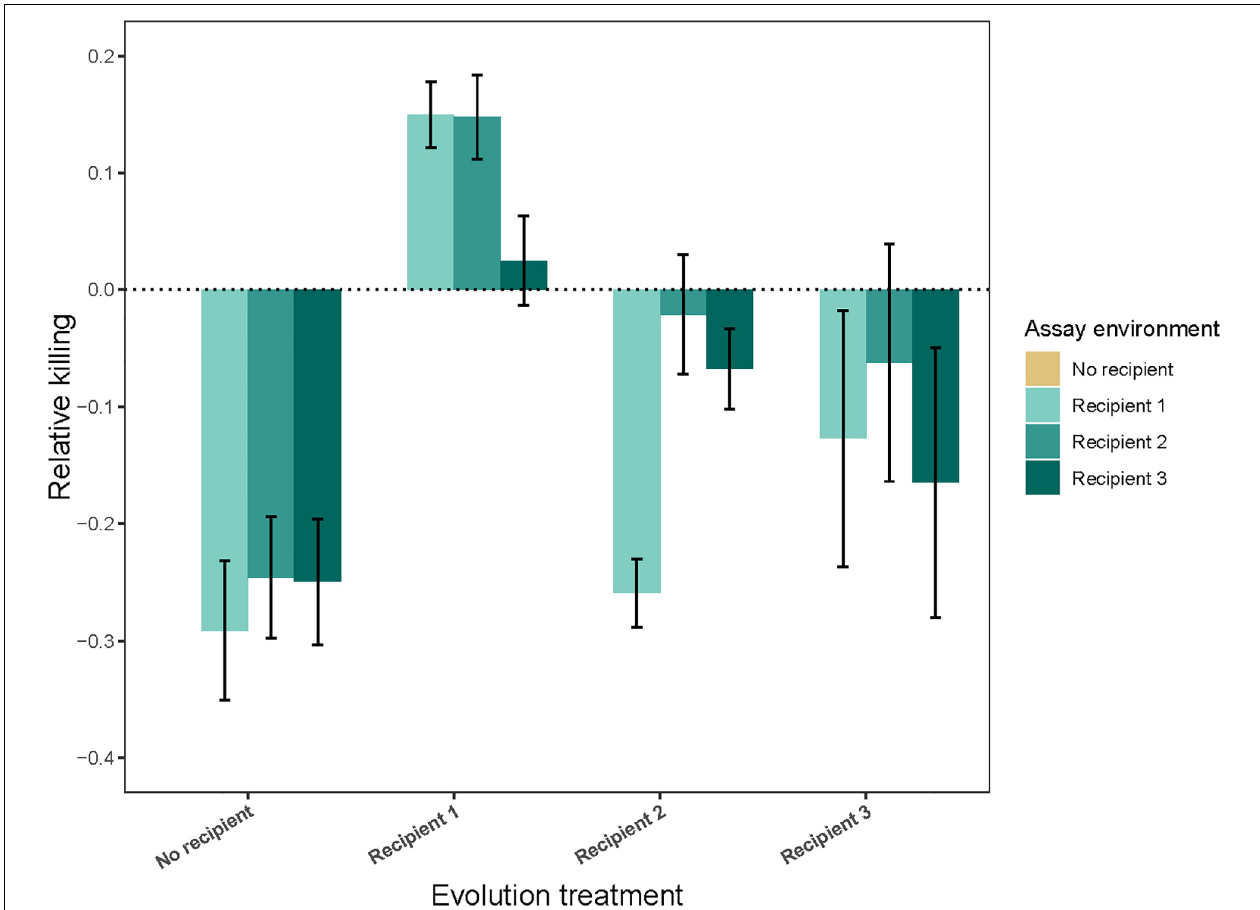
FIGURE 2 | Inhibition (Relative killing ability ± 95% CIPA) of populations evolved in the absence ( No recipient ) or presence ( Recipient 1 , Recipient 2 , or Recipient 3 ) of a non-evolving recipient strain, assessed in different assay environments (presence of either Recipient 1 , Recipient 2, or Recipient 3 ). Bars show the average of nine independently evolved populations that were each assayed using three